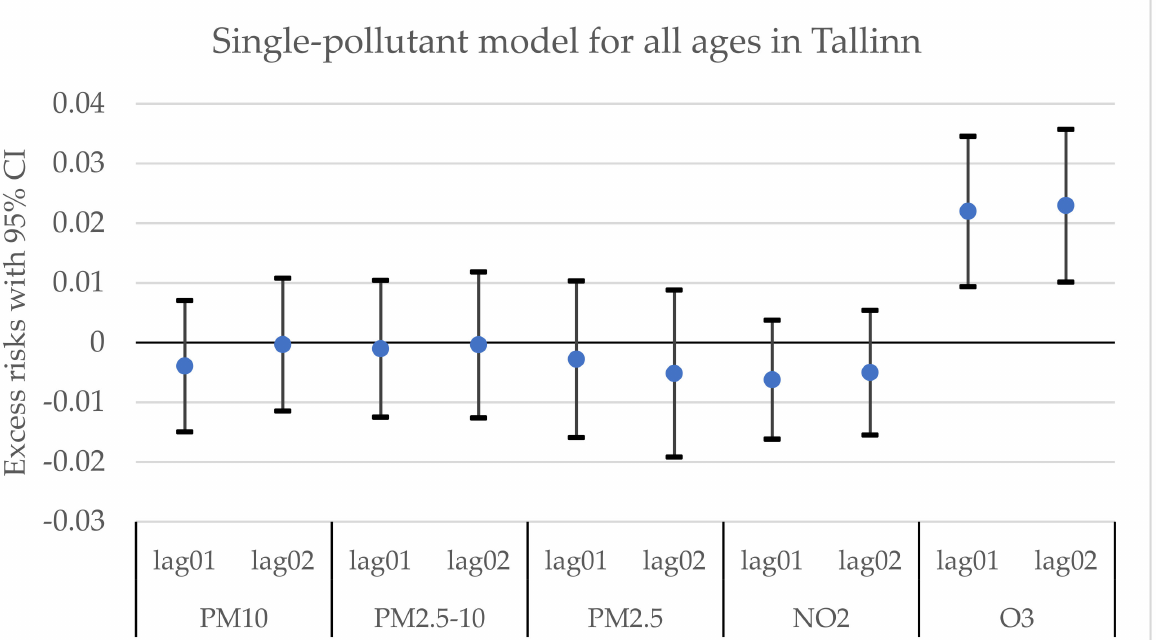
Figure A5. A single-pollutant model of the estimated change in daily mortality in all ages (with 95% CI) for an IQR increase in the concentrations (lag01 and lag02) of different air pollutants in